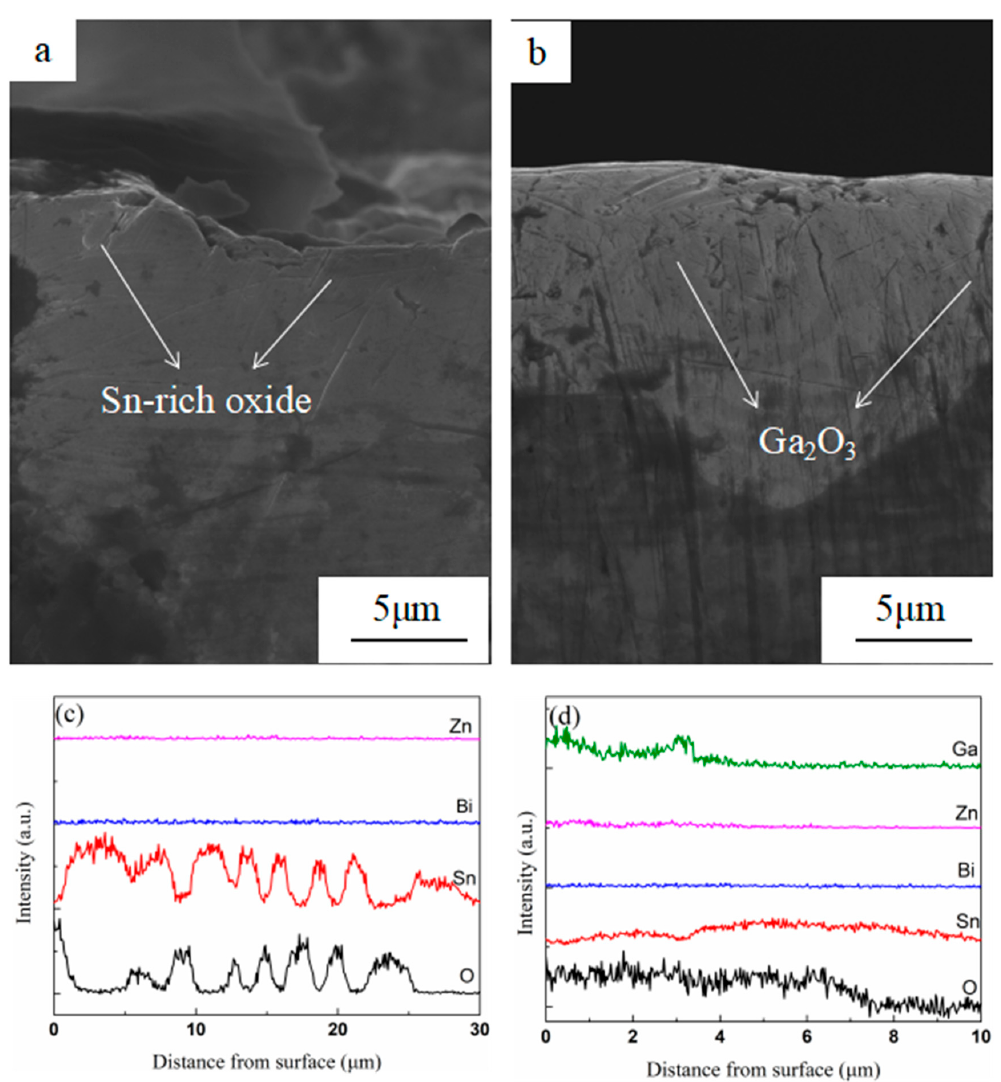
Figure 3. SEM image of cross section of low melting point alloys oxide film and corresponding concentration distribution of elements ( a , c ) Sn–Bi–Zn, ( b , d ) (Sn–50Bi–2Zn)–7Ga.